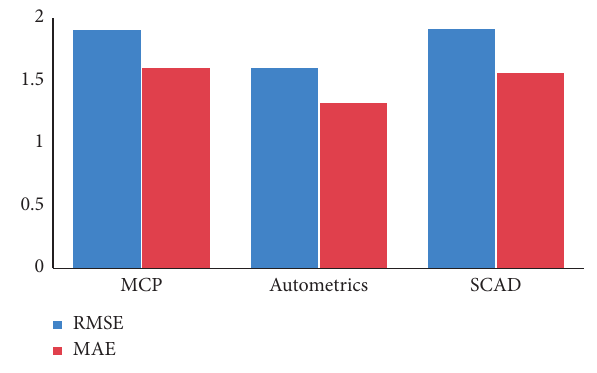
Figure 3: Forecast